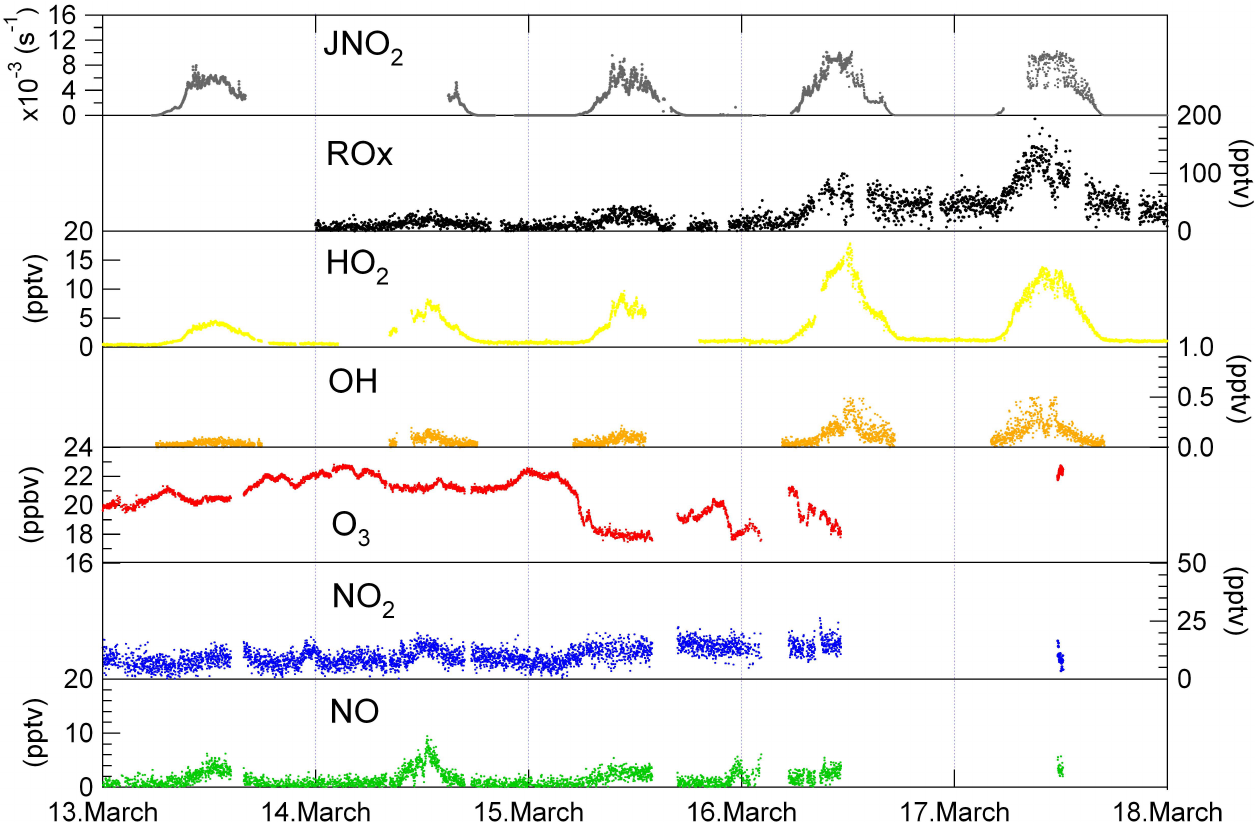
Fig. 8. Measured diurnal profiles of NO, NO 2 , O 3 , J NO